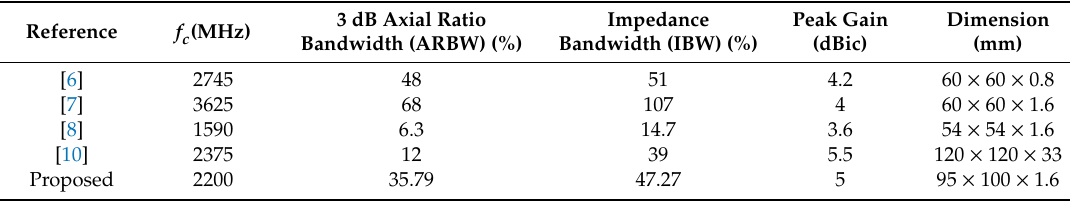
Table 3. Comparison of circularly polarized (CP) printed-slot antenna